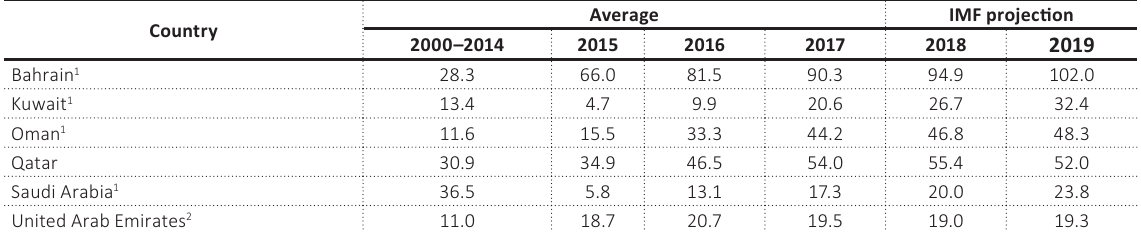
Table 6. Public gross debt (% of